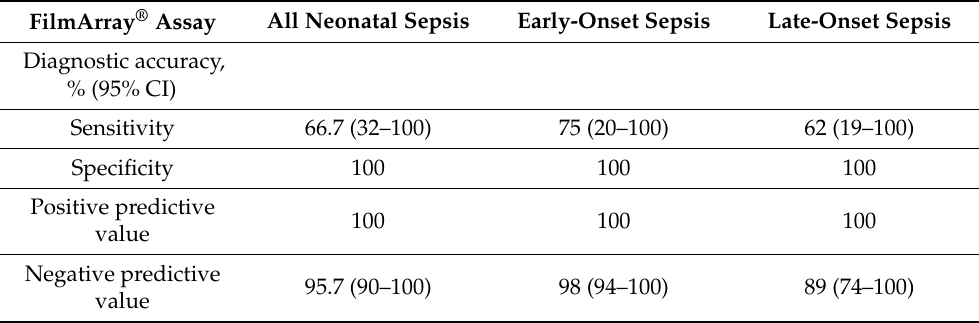
Table 4. Accuracy of the FilmArray ® BCID panel for the diagnosis of neonatal sepsis compared with blood